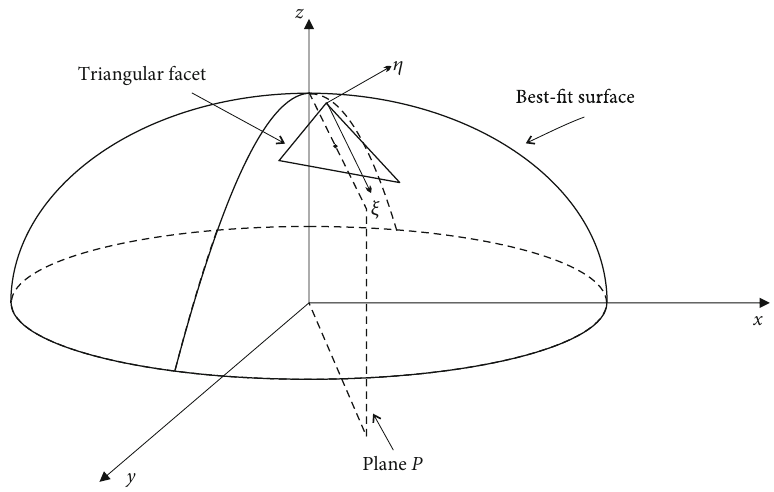
Figure 7: Local coordinate system ( ξ , η ) of a triangular facet in Ref.